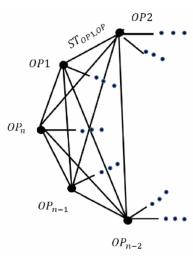
Figure 12. A partial graph H k with parametric weights for nodes and